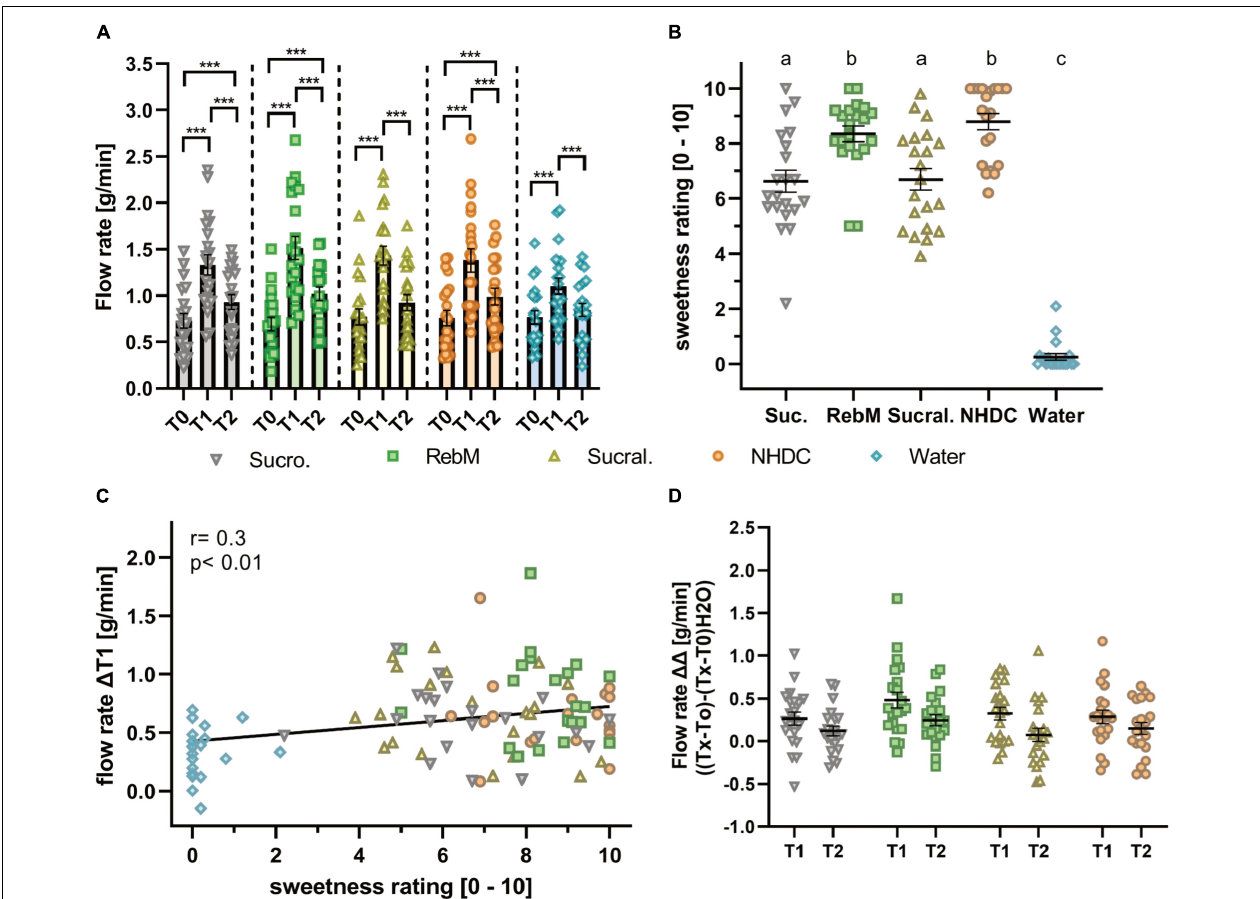
FIGURE 3 | (A) Flow rate (g/min) of unstimulated (T0) and stimulated saliva in the 1st (T1) and 2nd (T2) min after stimulation with the test solutions sucrose (suc.), RebM, sucralose (sucral.), NHDC, and water as control; presented as mean ± standard error of the mean (SEM); tested for difference with a two-way ANOVA